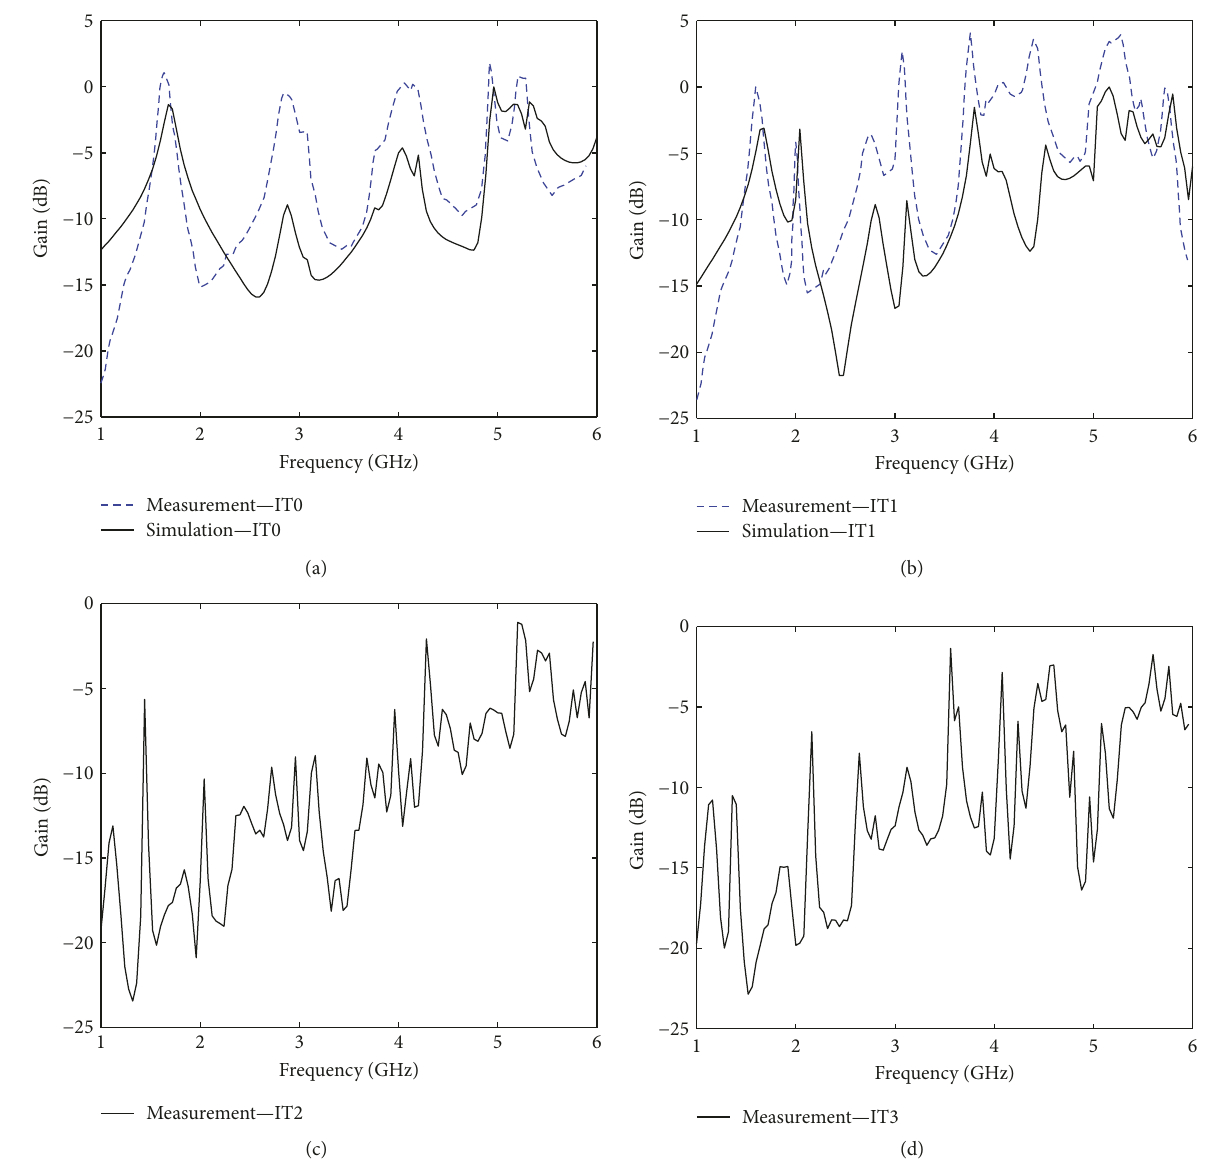
Figure 7: Simulated (black) and measured (blue) gain values for antennas: (a) A0, (b) A1, (c) A2, and (d)